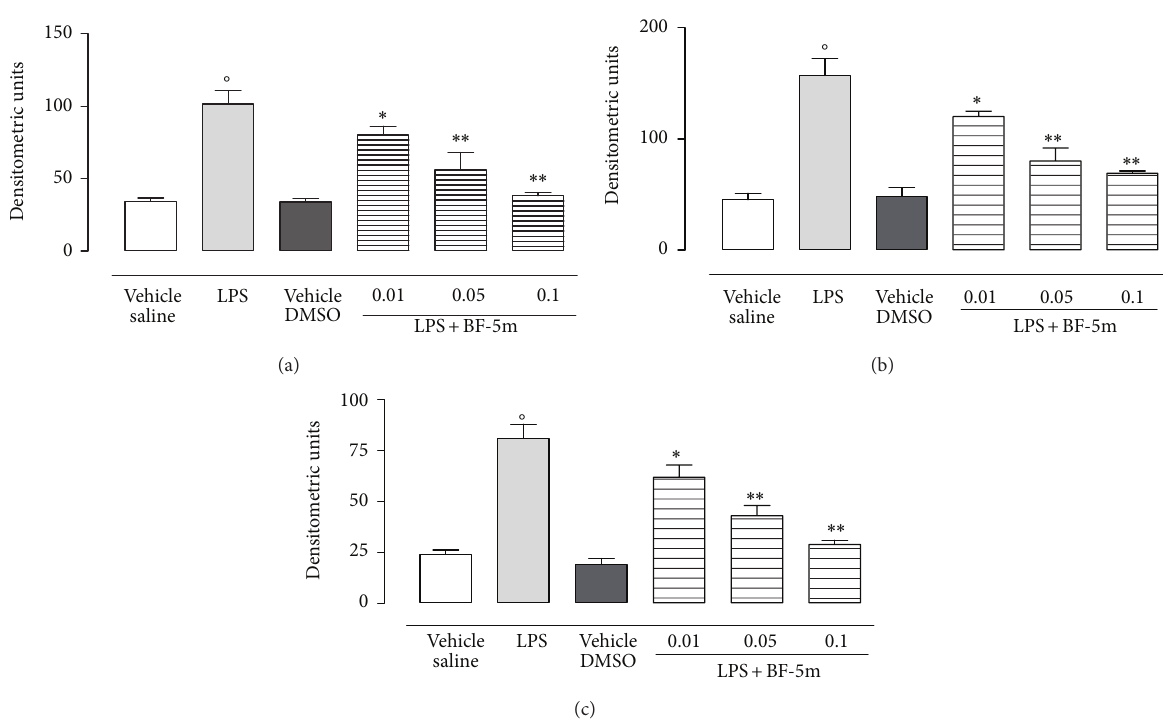
Figure 4: Western blotting analysis for NF- 𝜅 B. Injection of BF-5m (0.01; 0.05; 0.1 𝜇 M/rat) into the vitreous 24h after LPS-treatment of the rats reduced the expression of activated NF- 𝜅 B 105 (a), p50 (b), and p65 (c). Results are expressed as densitometric units and represented the mean ± SEM of 𝑛 = 6 observations for each group. ∘ 𝑃 < 0.01 versus vehicle saline group ∗ 𝑃 < 0.05 and ∗∗ 𝑃 < 0.01 versus LPS-treated rats.